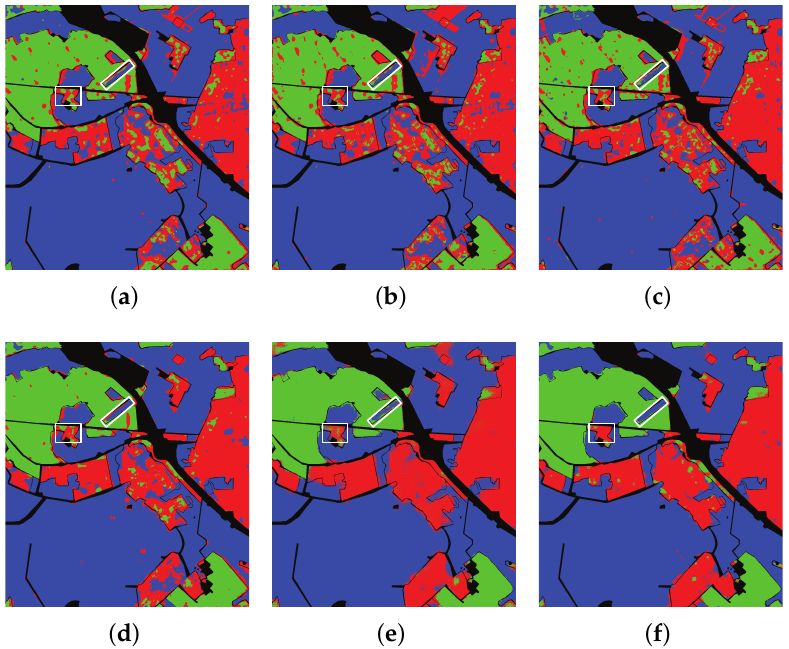
Figure 8. Classification results of Oberpfaffenhofen with various methods. ( a ) SVM. ( b ) SRC. ( c ) SAE. ( d ) CNN. ( e ) SFCN. ( f )